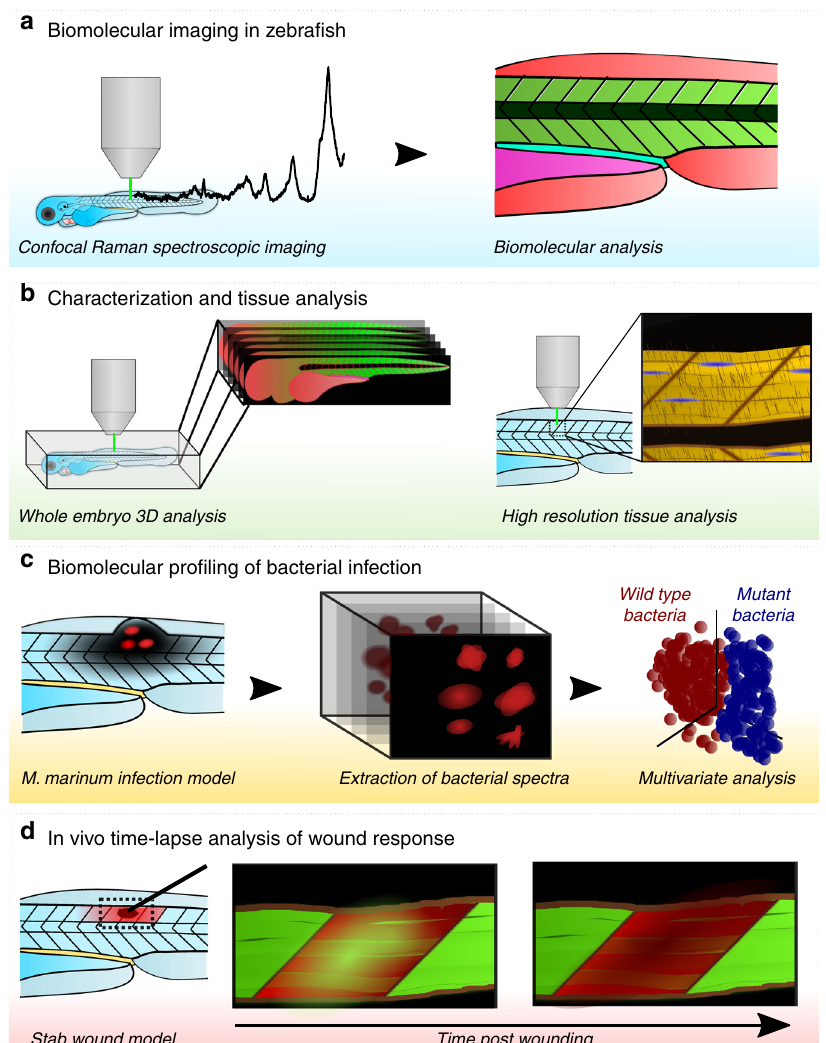
Fig. 1 Schematic overview of the confocal Raman spectroscopic imaging applications in zebra fi sh embryos developed in this study. a Confocal Raman spectroscopic imaging (cRSI) is a label-free imaging technique that uses molecular vibrations from Raman scattering to generate biomolecular images of the zebra fi sh embryo. b Characterization and tissue analysis of zebra fi sh embryos. cRSI can provide three-dimensional biomolecular information from an entire zebra fi sh embryo or high-resolution imaging of speci fi c tissue regions. c Biomolecular pro fi ling of bacterial infection. cRSI can be used to probe local biomolecular variation in bacterial populations after infection. We demonstrated this approach by using volumetric cRSI to discriminate between wild type and region of difference 1 ( Δ RD1) mutant Mycobacterium marinum in a zebra fi sh infection model. d In vivo time-lapse analysis of wound response. In vivo cRSI can be used to collect Raman spectroscopic images at multiple time points in living embryos and used for time-lapse biomolecular analysis. We demonstrated this concept by following a wound response model for 12 h in living zebra fi sh